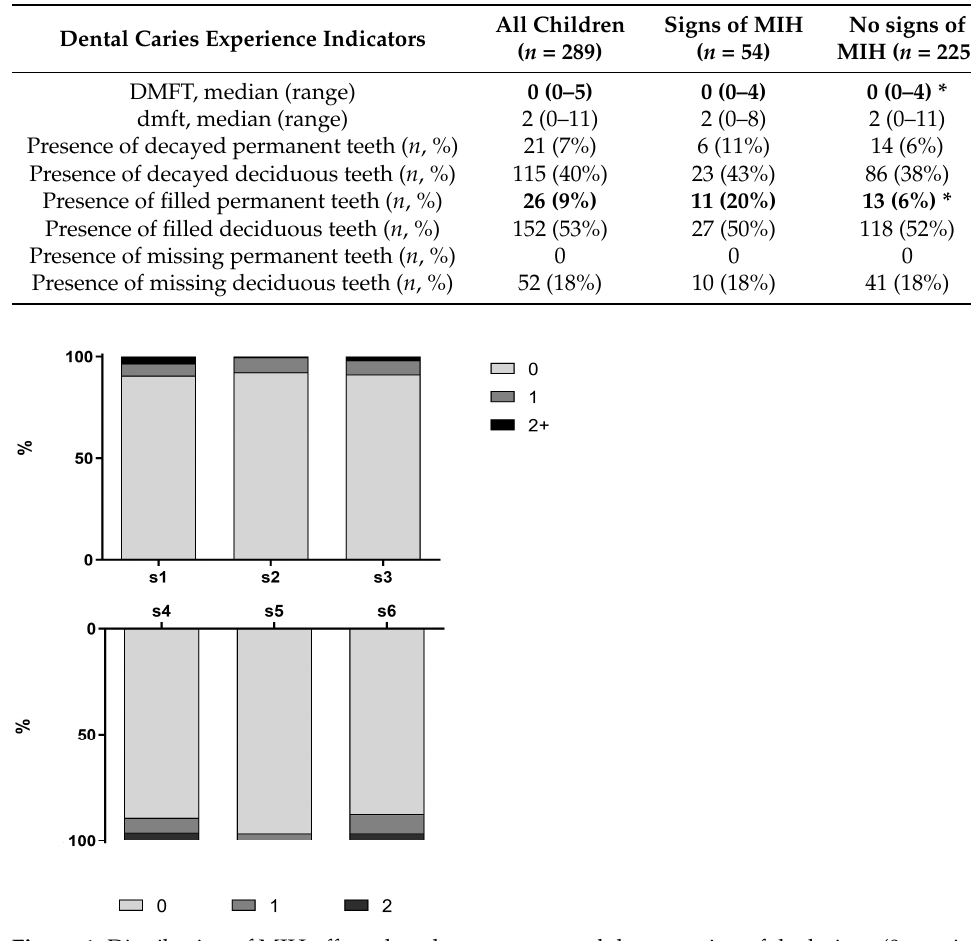
Figure 1. Distribution of MIH-affected teeth per sextant and the extension of the lesions (0: no signs of MIH, 1: small lesions, 2+ lesions encompassing several surfaces).